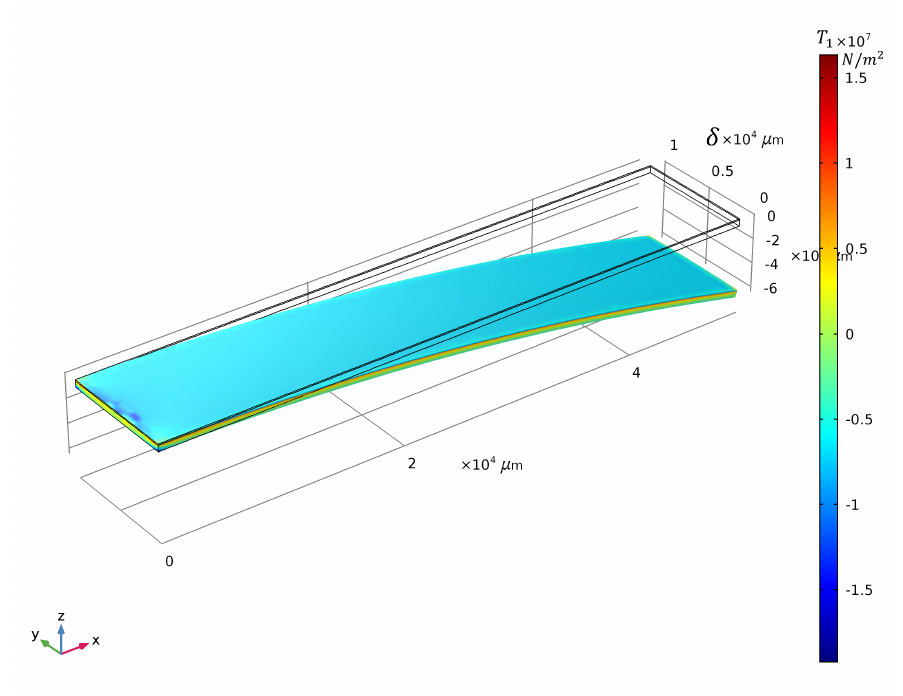
( x , y , z ) (N/m 2 ) at v c = 60 V and pre